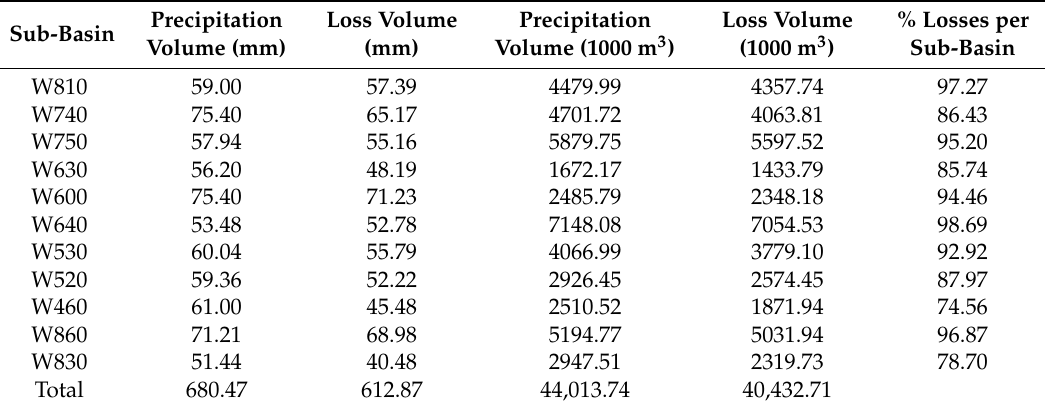
Table 16. Basin losses of 2012.